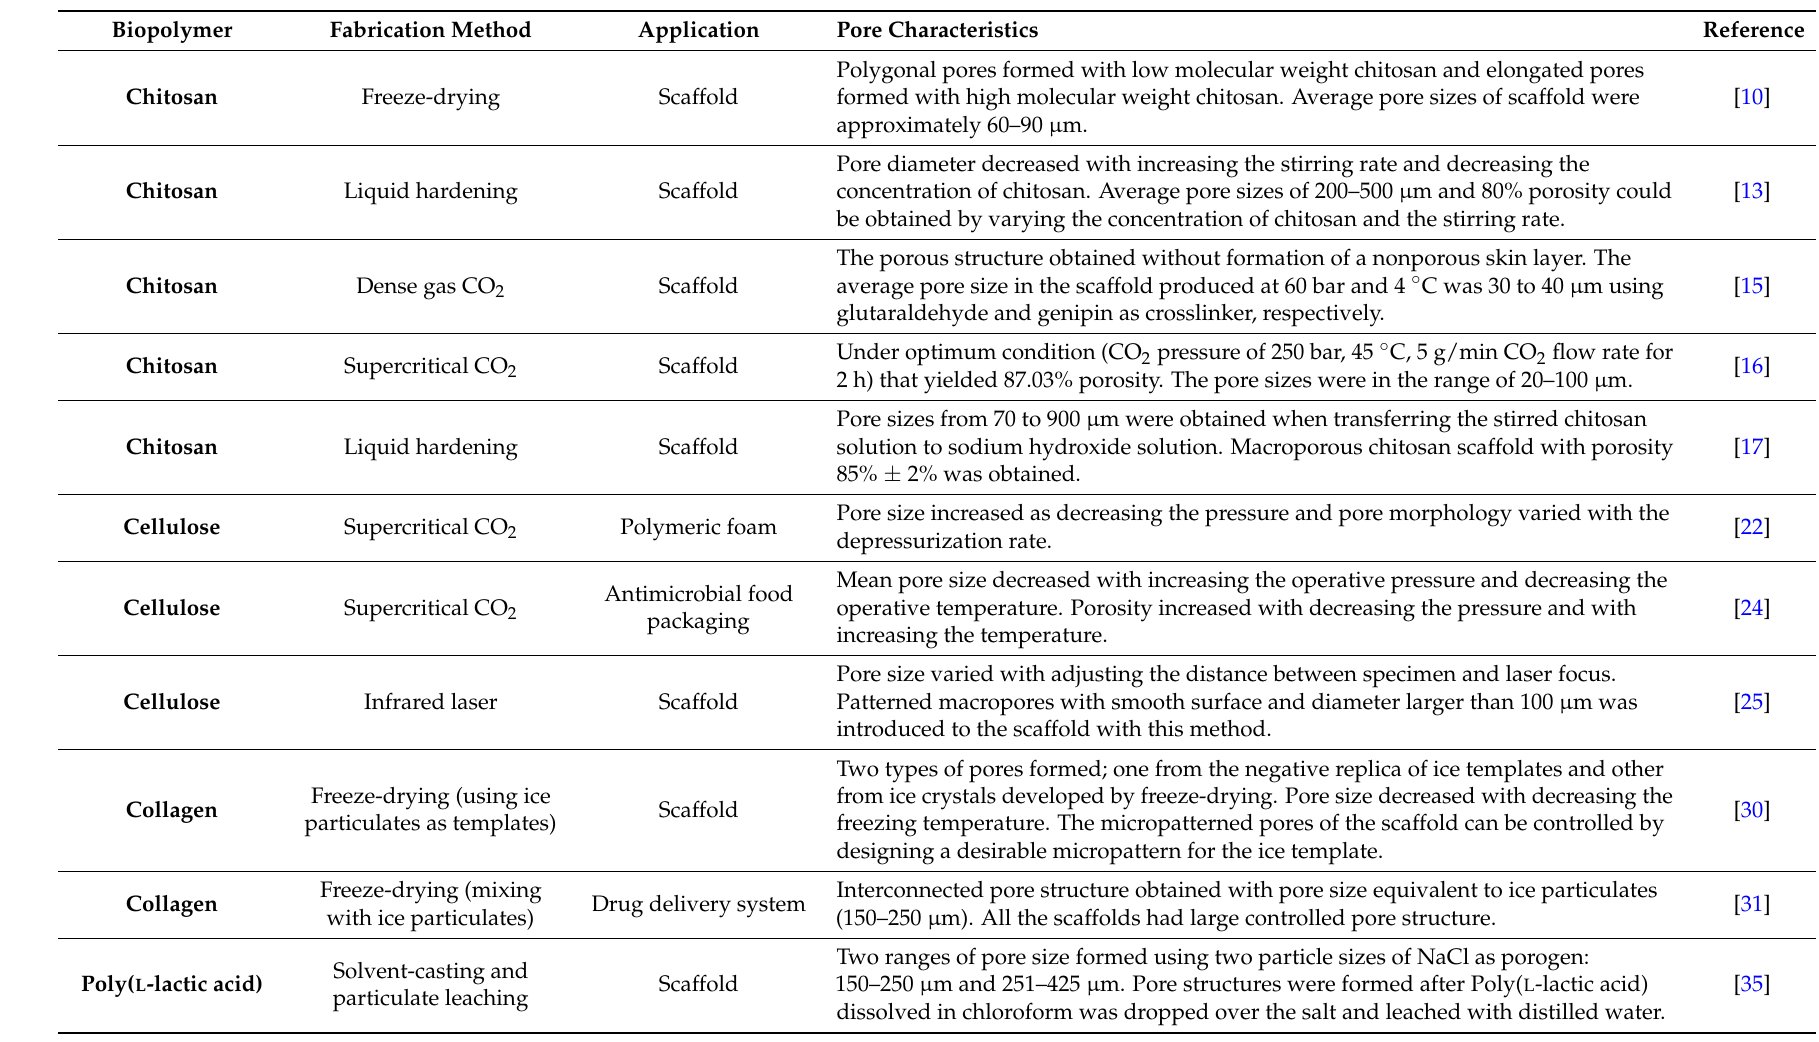
Table 1. An overview of pore characteristics of biomaterials fabricated with different